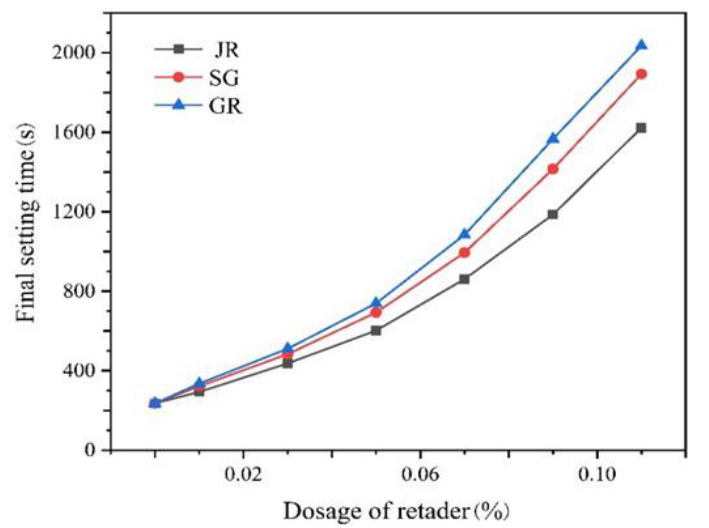
Figure 4. Effects of different kinds of retarders on the final setting time of dental gypsum at different dosages (ww − 1 ).